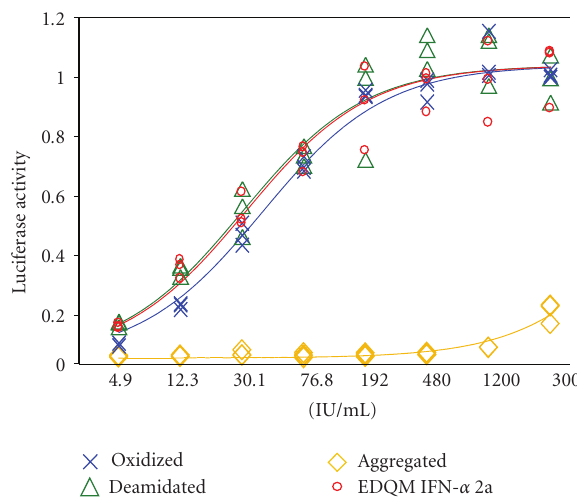
Figure 7: Validation of the RGA. Known amounts of IFN- β pre- determined by routine AVA were spiked into the culture media and subjected to RGA. Three expected potency ratios of the internal standard concentrations were employed, that is, 80%, 100%, and 120%. Samples were run as four replicates and potency was determined by comparing to the in-house reference